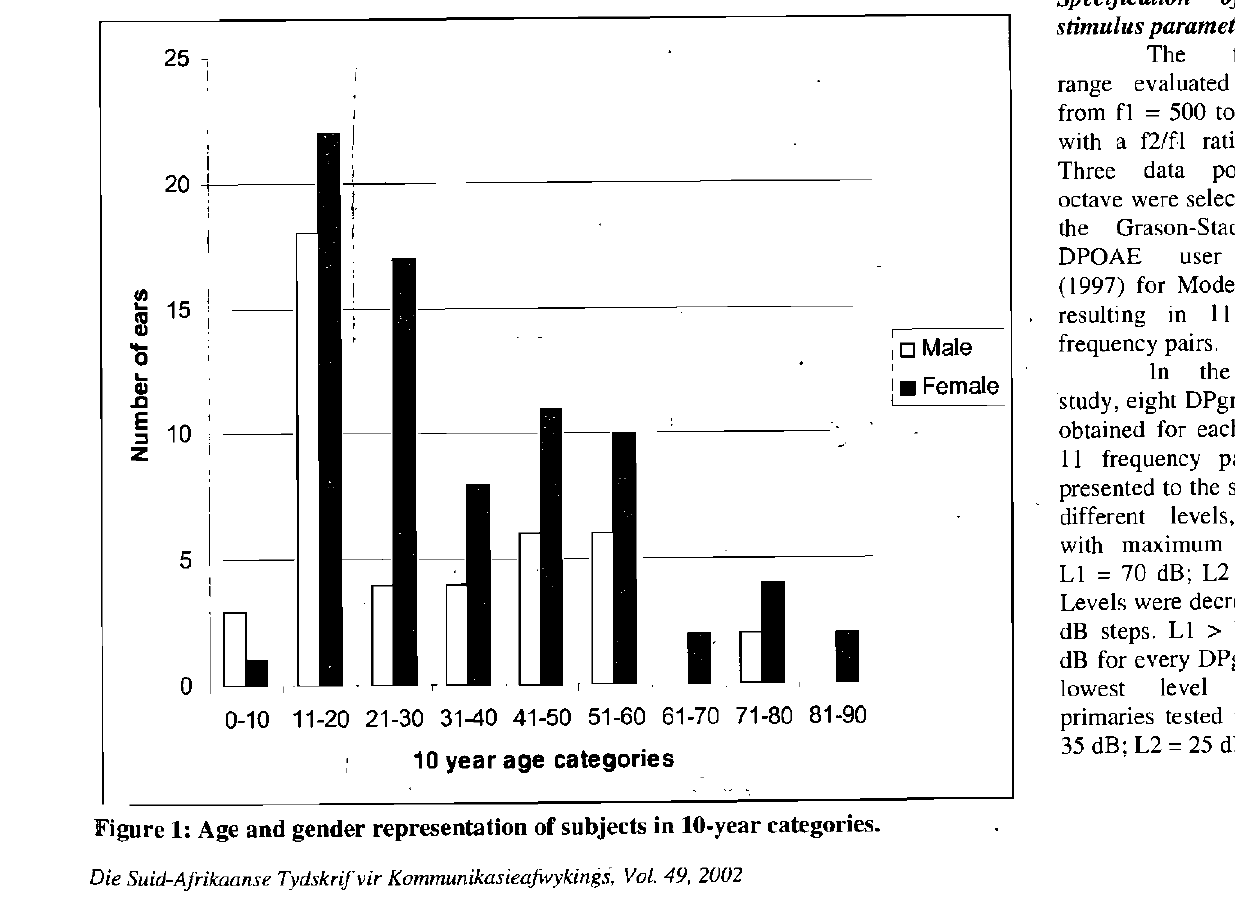
Figure 1: Age and gender representation of subjects in 10-year